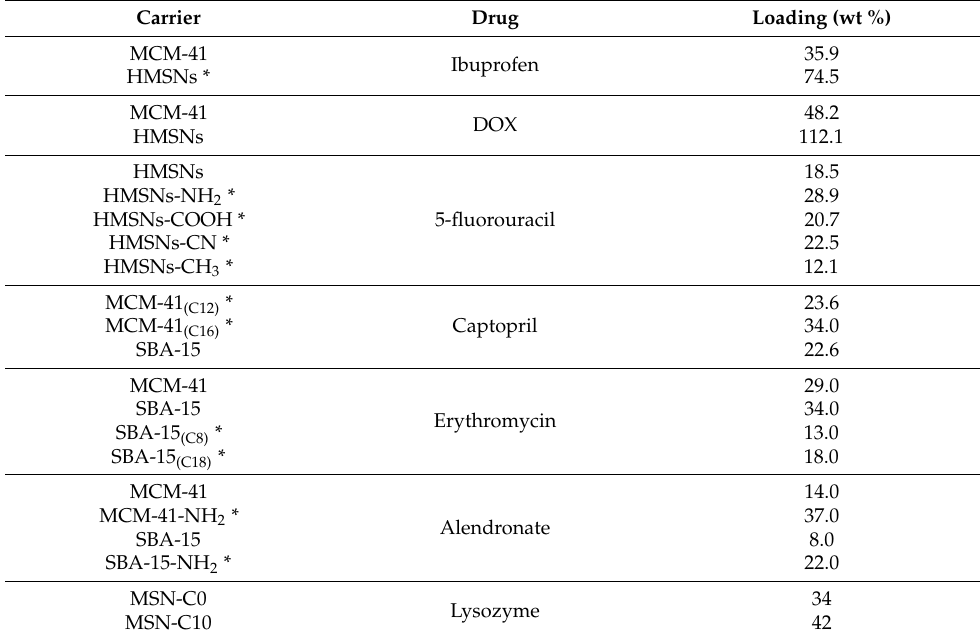
Table 3. Comparison of loading of various drugs in unfunctionalized and functionalized MSNs of different types. Reprinted with permission from [174]. Copyright 2018